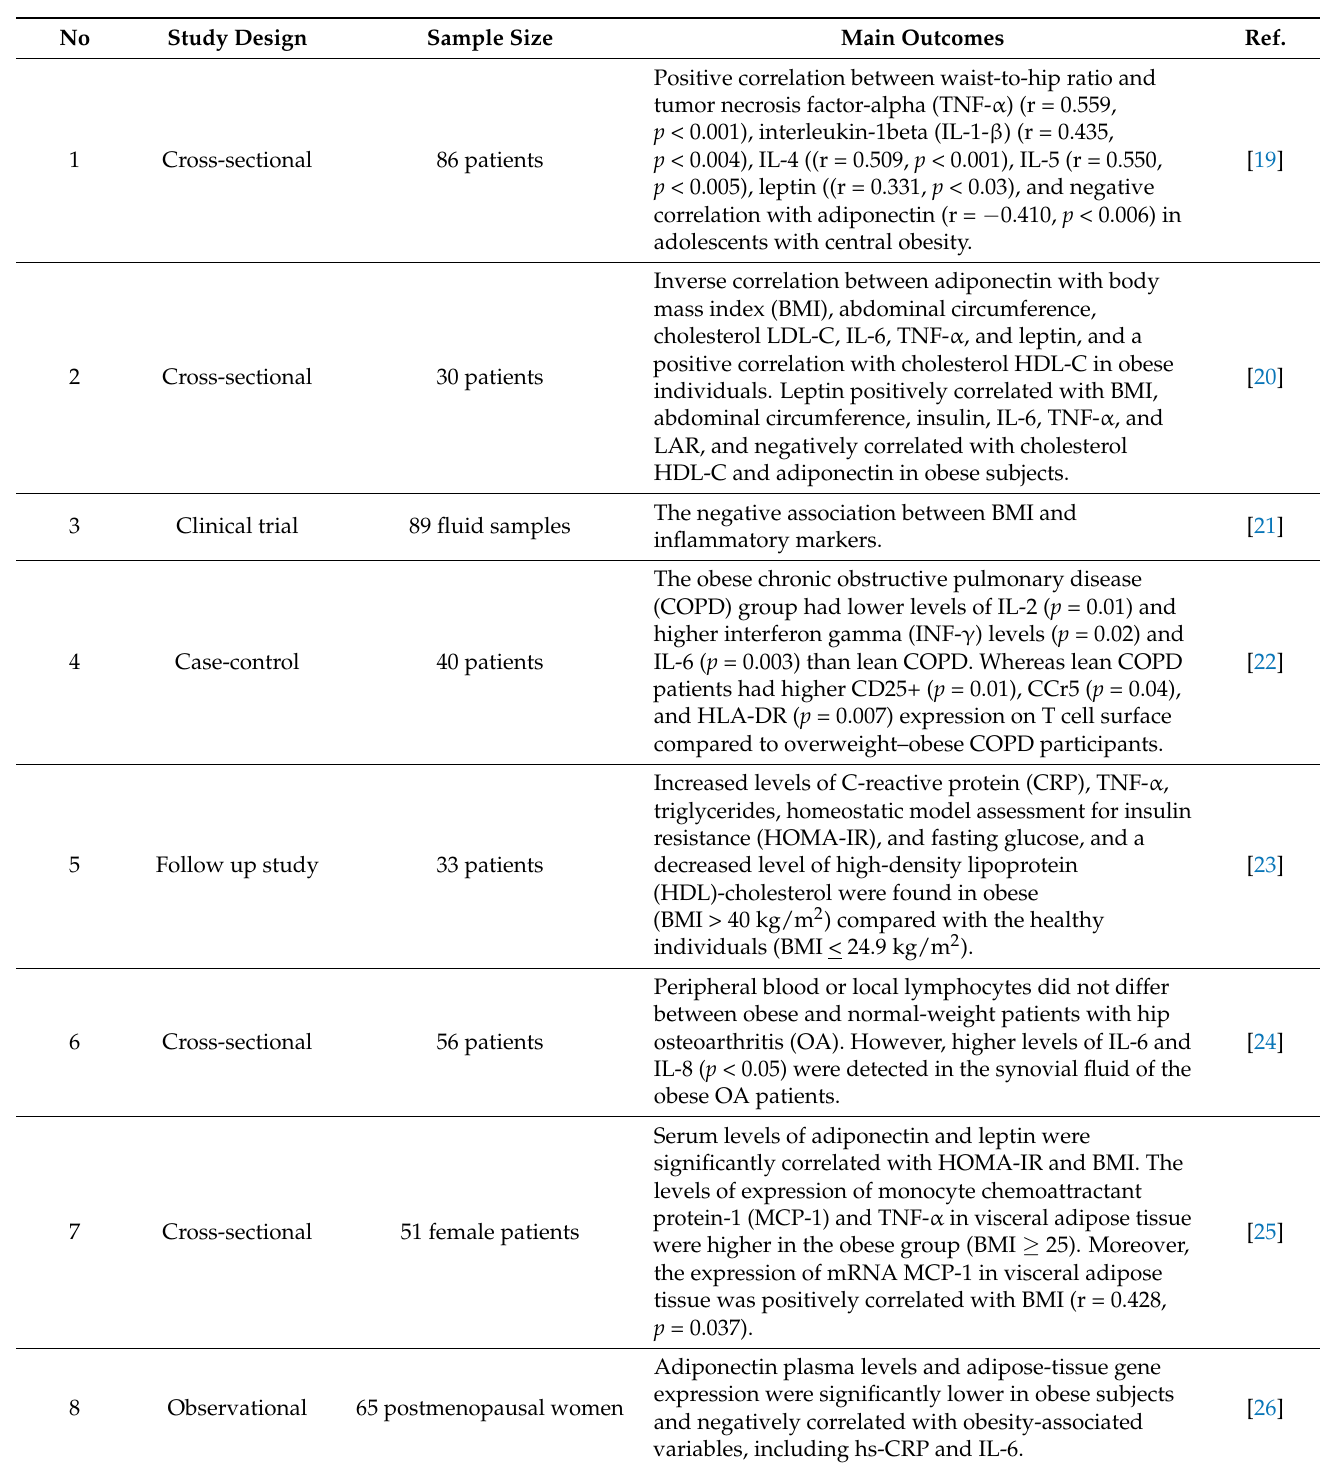
Table 1. Summary of the results and characteristics of selected